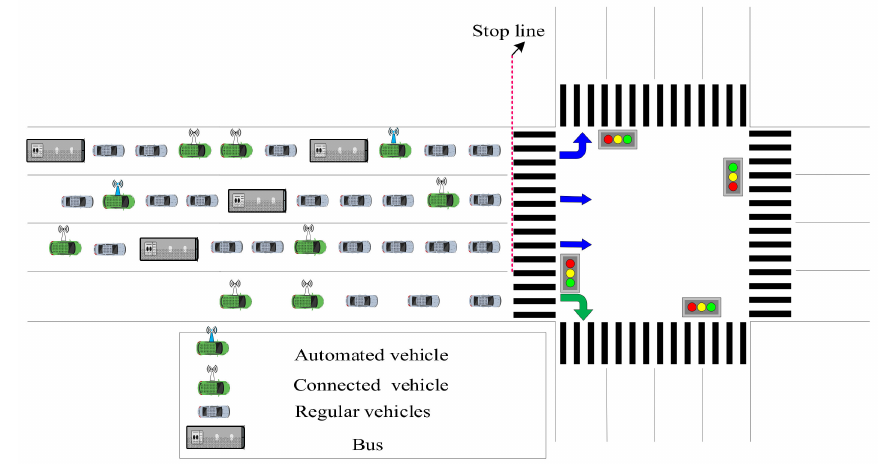
Figure 3. Future tra ffi c flow